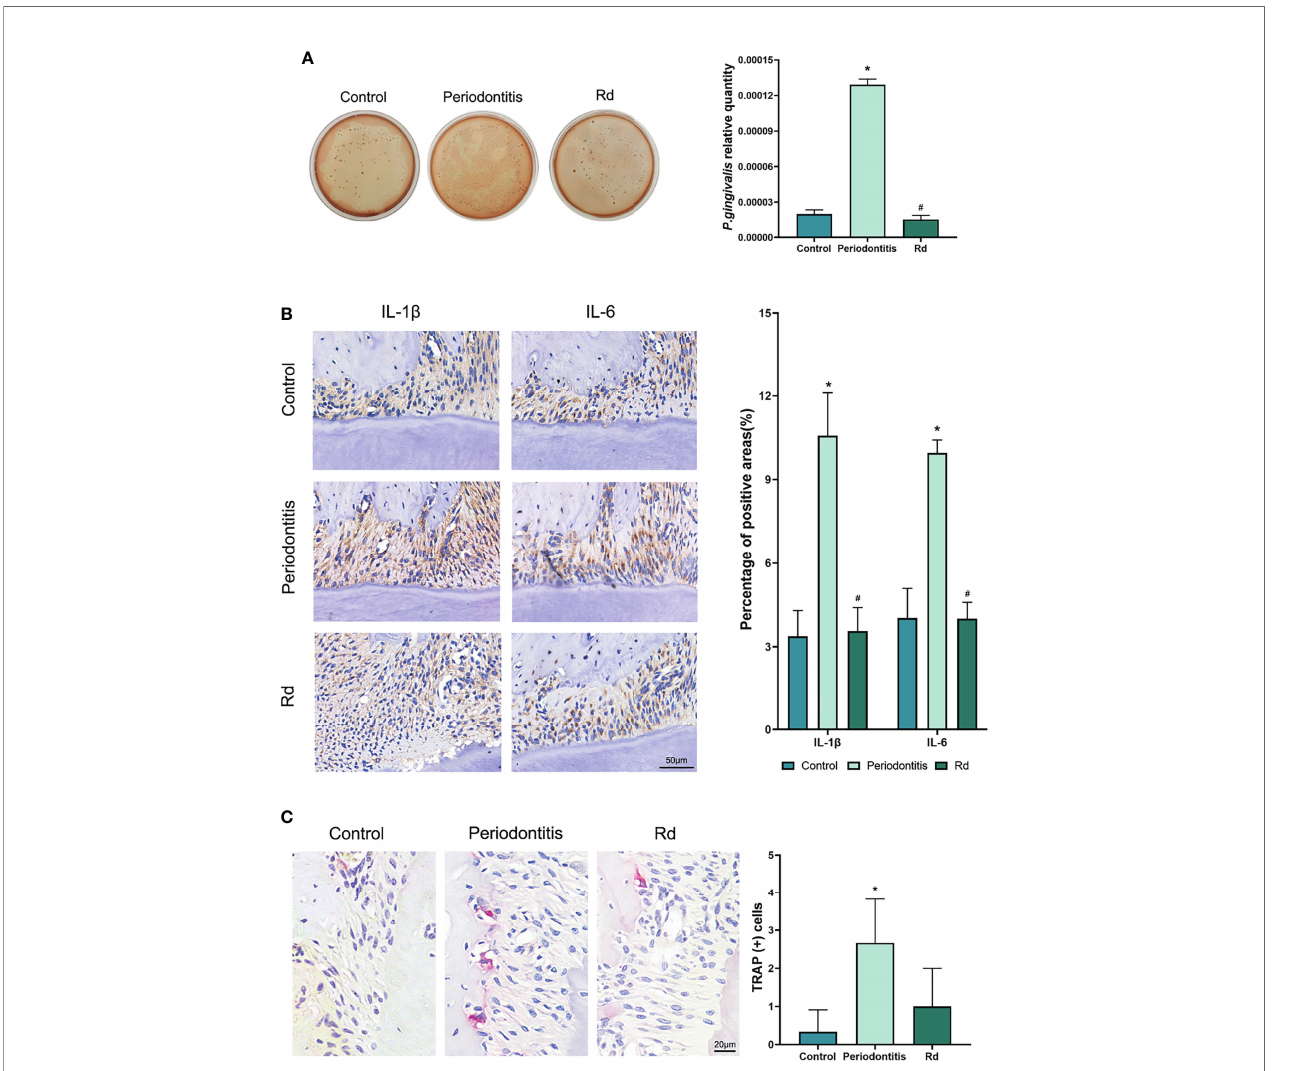
FIGURE 6 | Effects of ginsenoside Rd on the P. gingivalis quantity, local in fl ammation, and osteoclastogenesis in vivo . (A) The total bacterial load in the GCF was shown by the plate spreading method, and the subgingival P. gingivalis abundance was quantitated by qRT-PCR. (B) Photographs of immunohistochemical staining and positive rates of IL-1 b and IL-6 cytokines in tissue sections. (C) Photographs and counts for multinucleated TRAP (+) cells in tissue sections. The results are shown as mean ± SD ( n = 3). * p < 0.05 versus the normal control; # p < 0.05 versus the periodontitis